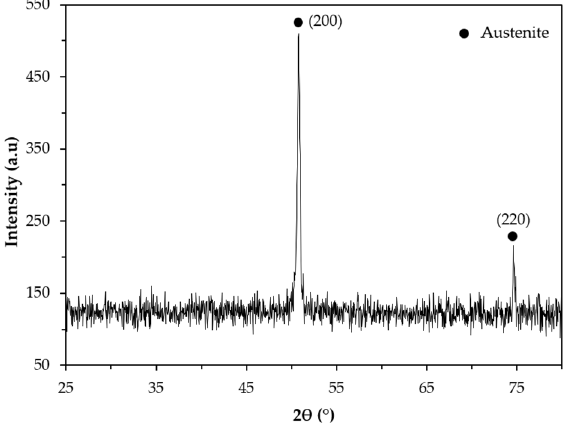
Figure 9. X-ray diffraction (XRD) pattern of the base metal in the 2 θ range of 25°–80°.